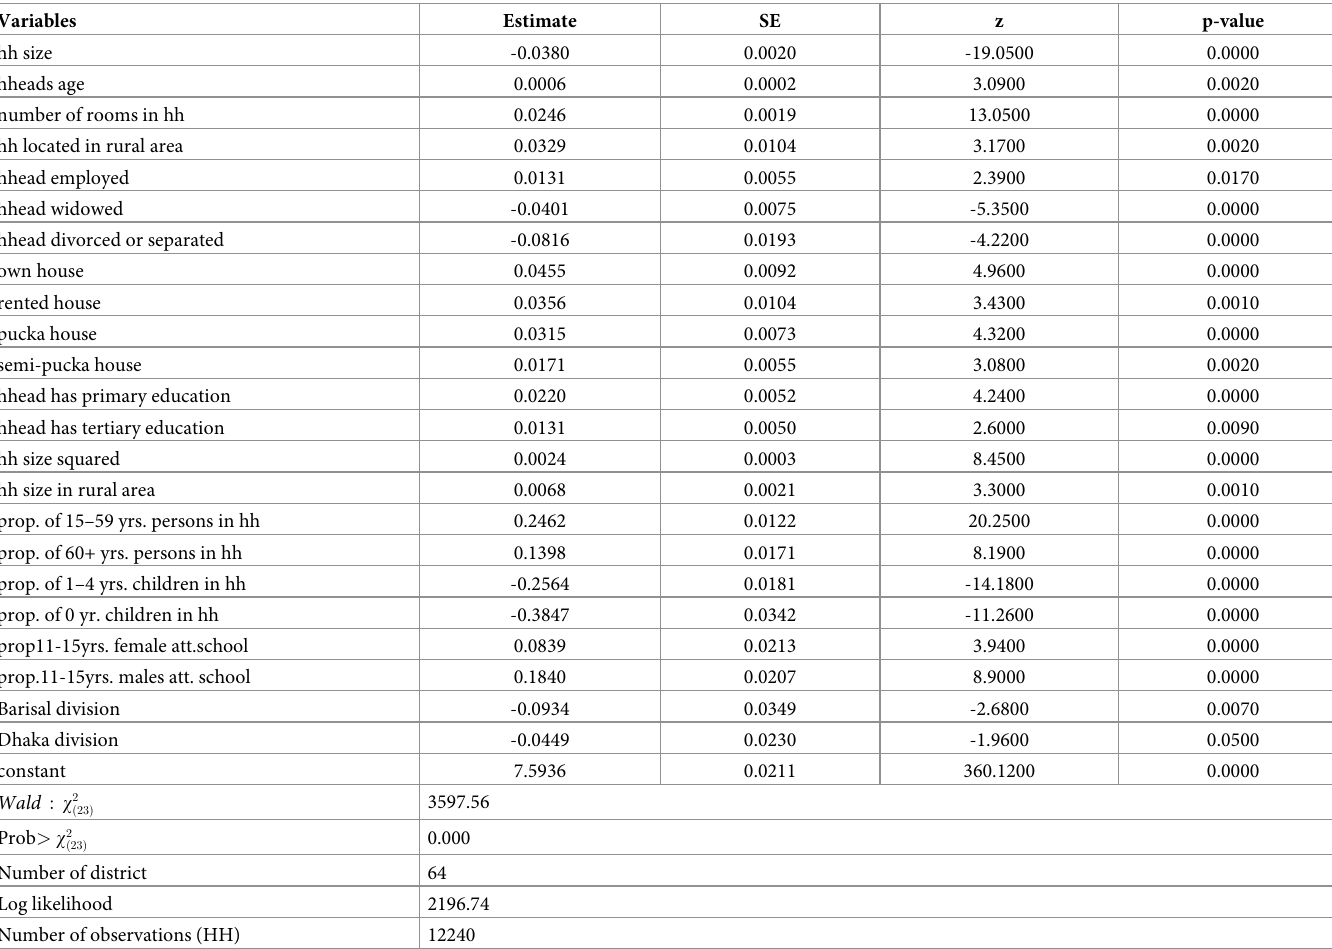
Table 2. Estimate of fixed effect parameters along with their significance level of the fitted 2-level linear mixed-effects model (BHF model) using REML method of estimation.